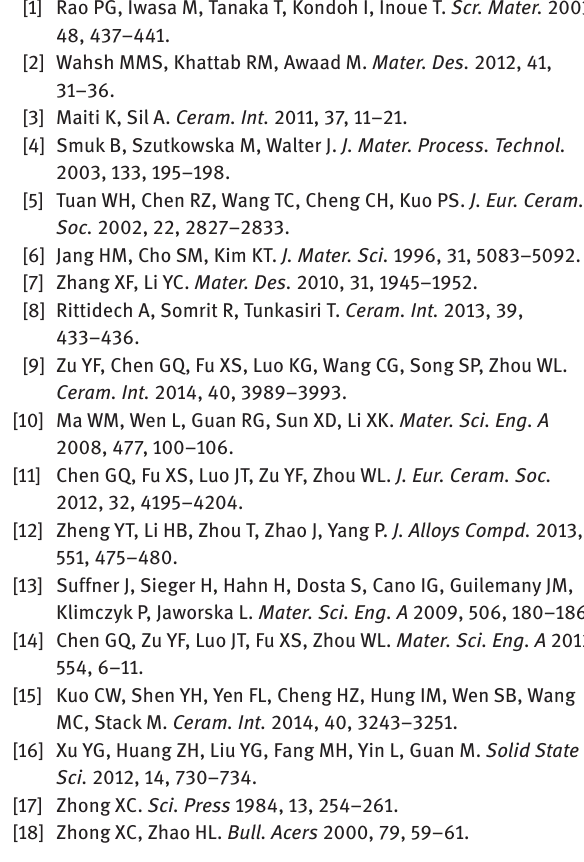
, (B) Z , (C) Z after thermal shock tests at Δ T = 1100 ° 1 2 3